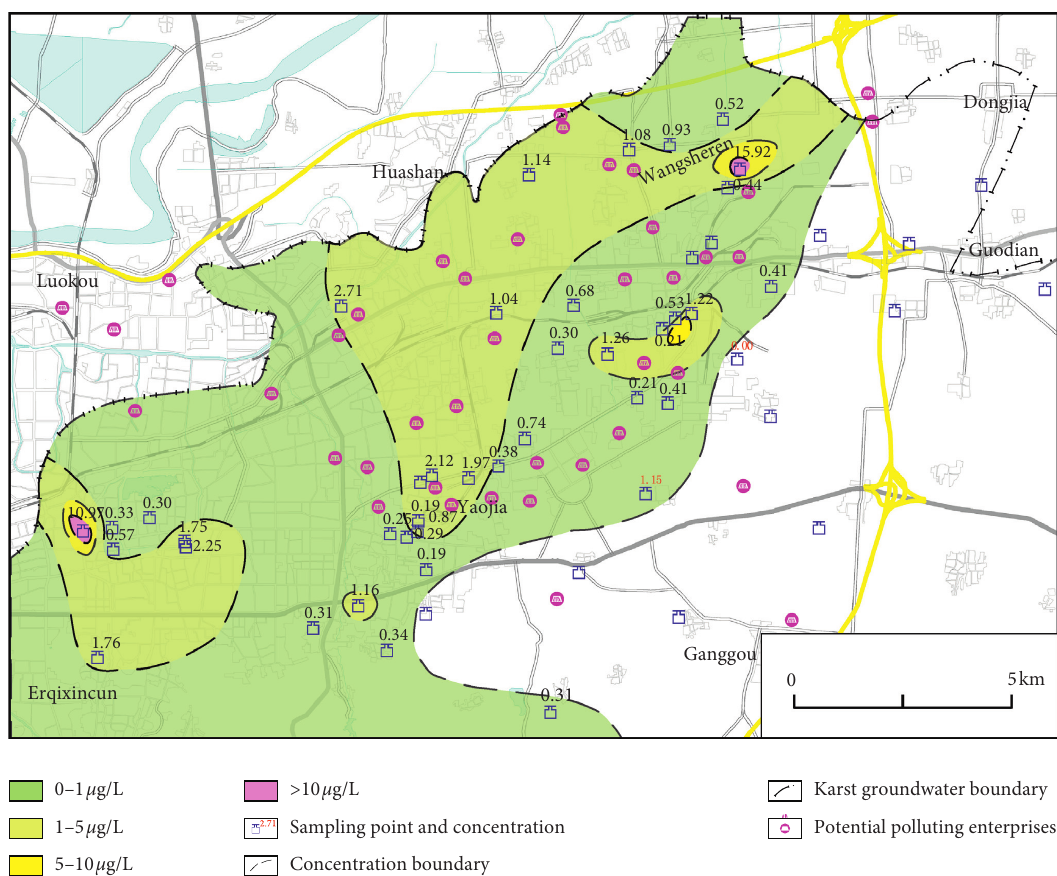
Figure 7: Distribution of the trichloromethane concentration in fractured karst water in northeast spring